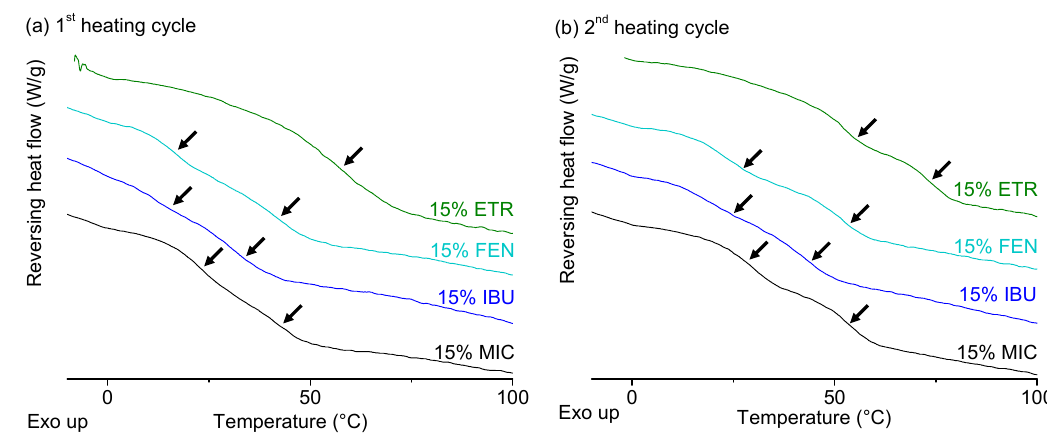
Figure 11. Reversing heat flow, recorded in the first ( a ) and second heating ( b ) cycle of PEtOx / PPrOx (1 / 1) ASDs with etravirine (ETR), fenofibrate (FEN), ibuprofen (IBU) and miconazole (MIC). The drug loading was fixed at 15% for all four formulations. Glass transitions are indicated with arrows in both first (left) and second heating cycle (right). Created with Origin 8.5 from OriginLab (Northampton, MA, USA). Table 5. T g s of PEtOx, PPrOx, PEtOx / PPrOx (1 / 1) without drug and the respective polymer blend with 15% etravirine (ETR), 15% fenofibrate (FEN), 15% ibuprofen (IBU) and 15% miconazole (MIC). The ratio of the two T g s was calculated for each formulation.